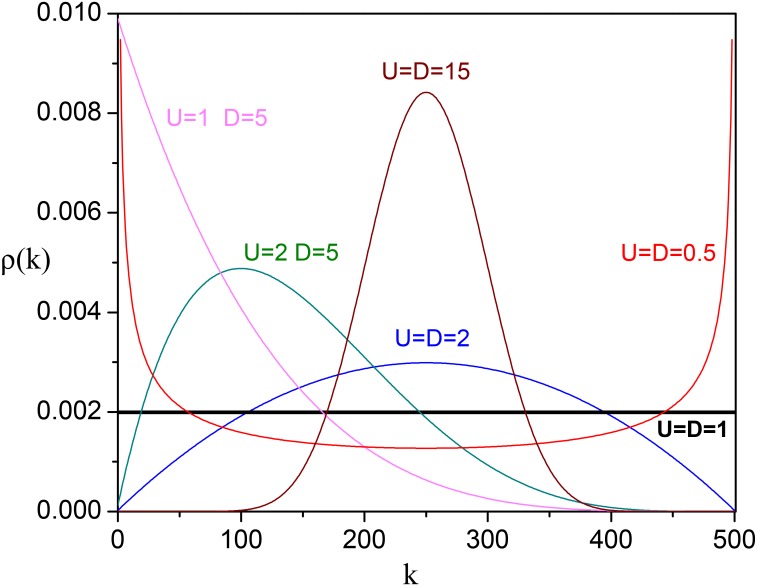
Stationary distributions for different values of U and D.Probability distributions of finding the network with k nodes in state 1 at equilibrium for different values of U and D. The number of variable nodes is N = 500.